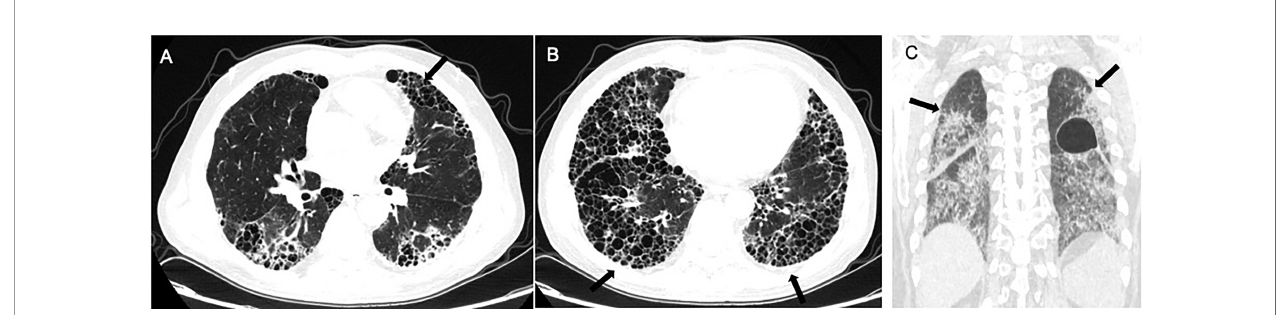
FIGURE 2 | Radiological imaging pattern of CTD-ILD. (A) “ anterior upper lobe ” sign. (B) “ exuberant honeycombing ” sign. (C) “ straight-edge ” sign. All these signs are indicated by